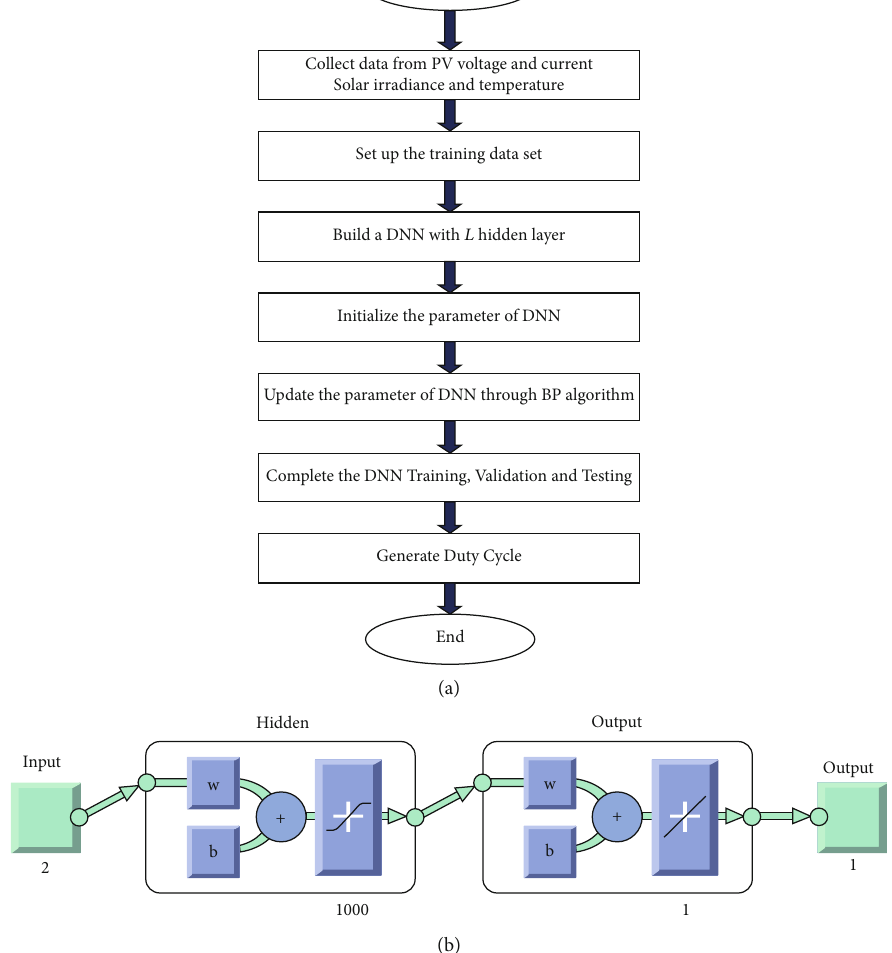
Figure 4: (a) Flow chart of the DNN model for the PV-MPPT system. (b) DNN model for the PV-MPPT system. Best validation performance is 4.8377e-13 at epoch 80